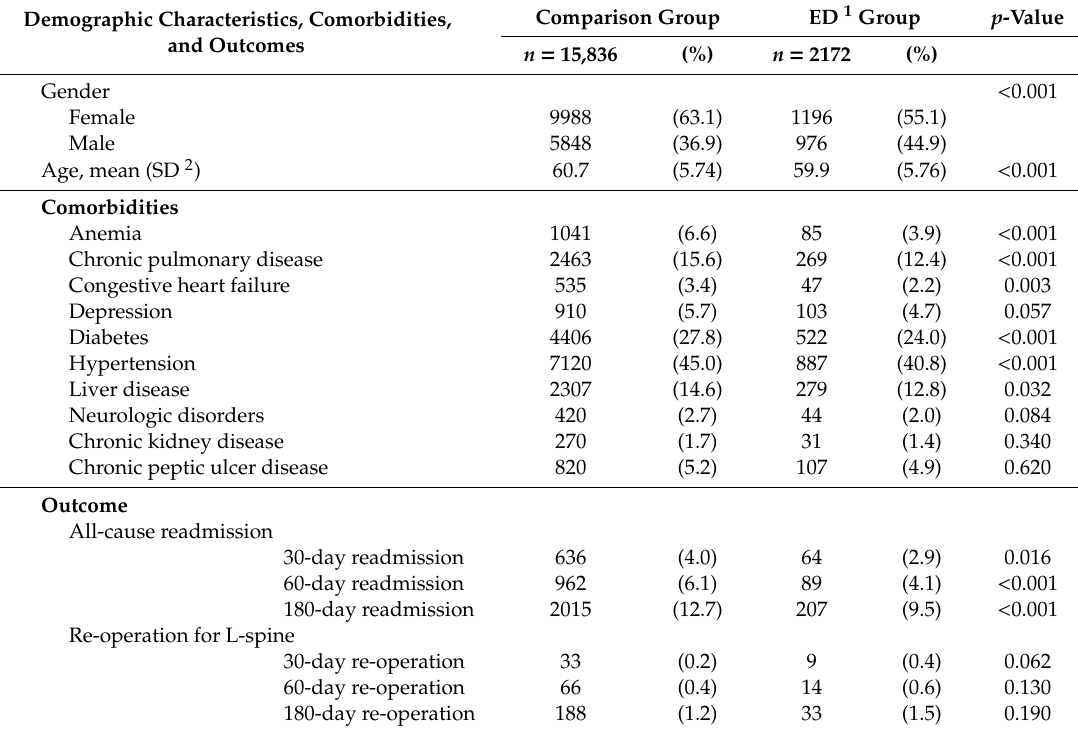
Table 1. Demographic characteristics, comorbidities, and outcomes of comparison and early discharge (ED) groups, 2011–2013 ( n = 18,008).